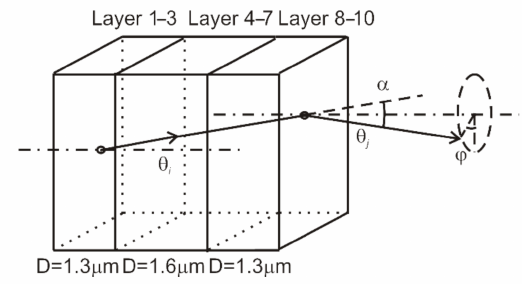
Figure 6. Numerical scheme for the reconstruction effort.